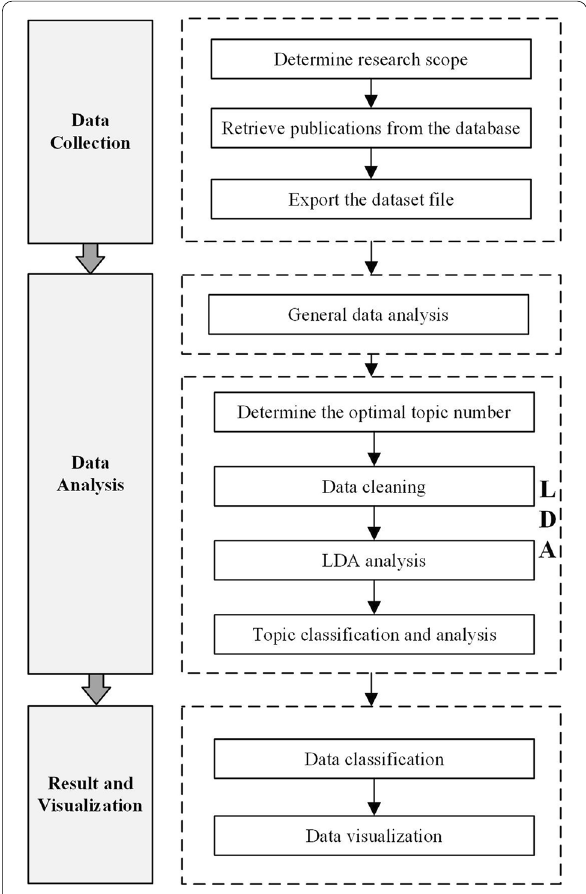
Fig. 1 Workflow of the study. Schematic of the organization of the study into 3 parts: (1) data collection based on Web of Science, (2) data analysis using LDA method, and (3) results analysis and